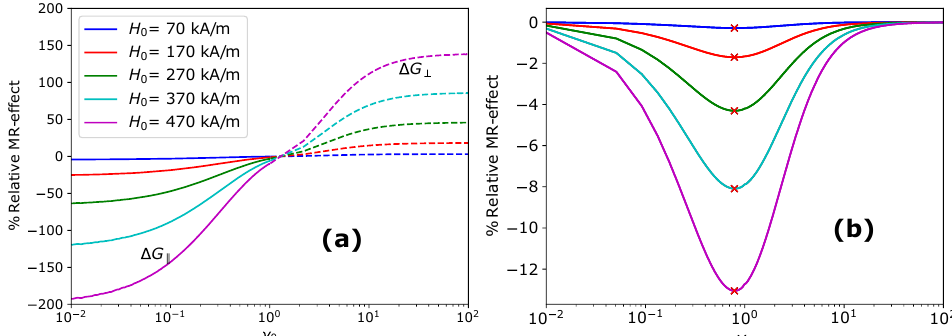
Figure 7. The magneto-rheological (MR) effect: ( a ) The %MR-effect in the x - y plane along the field direction (solid lines) and perpendicular to the field direction (dashed lines) as a function of the initial aspect ratio γ 0 ; ( b ) The % MR-effect in the plane of isotropy (the y - z plane) as a function of the initial aspect ratio γ 0